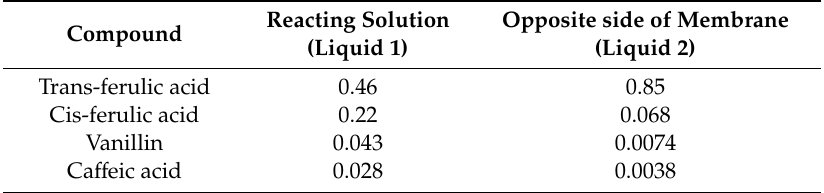
Table 1. Concentration (mM) of some organic compounds in the reacting solution of the MR and at the opposite side of the membrane after 5 h. At time 0, the aqueous solutions on both sides contained only trans-ferulic acid with a 1 mM concentration.